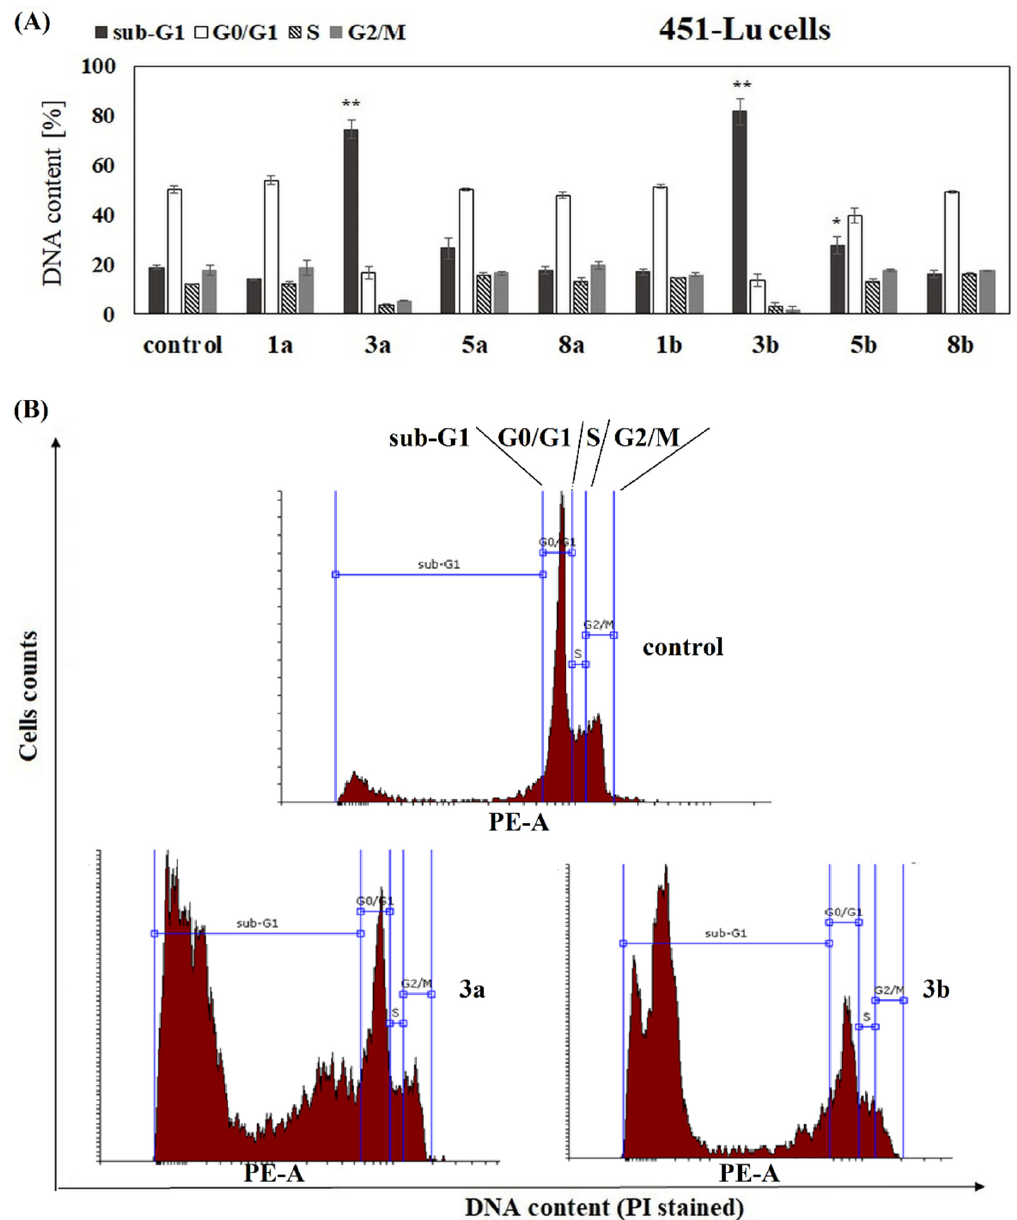
Figure 4. The distribution of 451-Lu cells in major phases of the cycle. Cells were cultured for 72 h in the presence of the studied chemicals at a concentration of 100 µ M. The statistical significance was determined (* p < 0.05 and ** p < 0.001) ( A ). Representative histograms for effects obtained in 451-Lu cell line are shown ( B ).